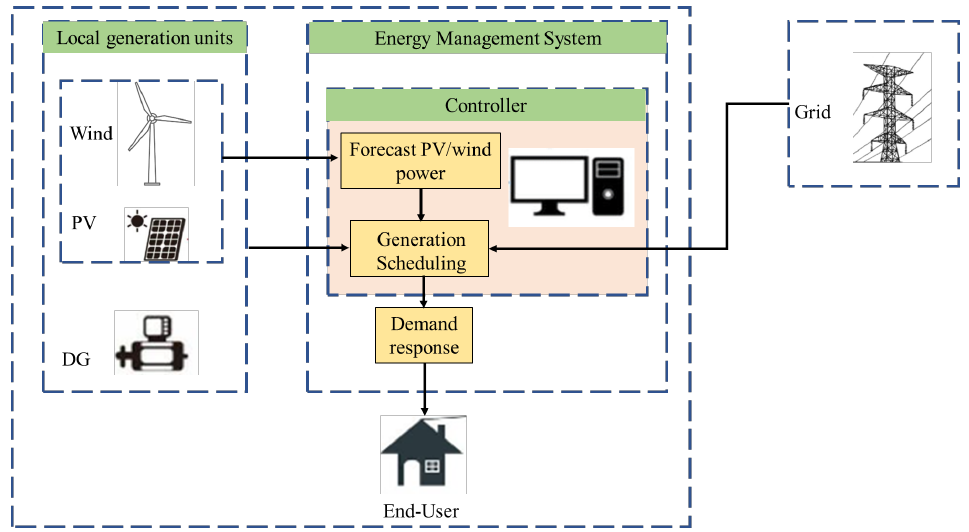
Figure 1. The proposed framework of the decentralized energy management